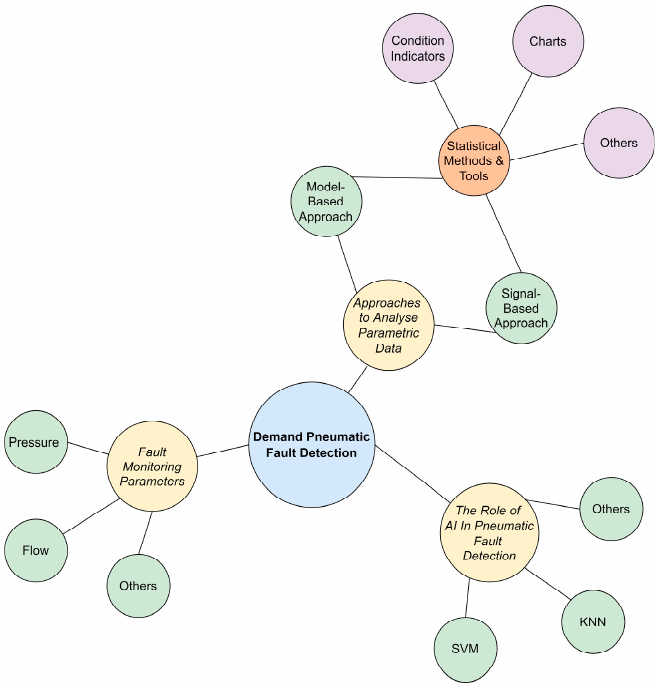
Figure 3. Main topics concerning demand-oriented pneumatic fault detection covered in this review.